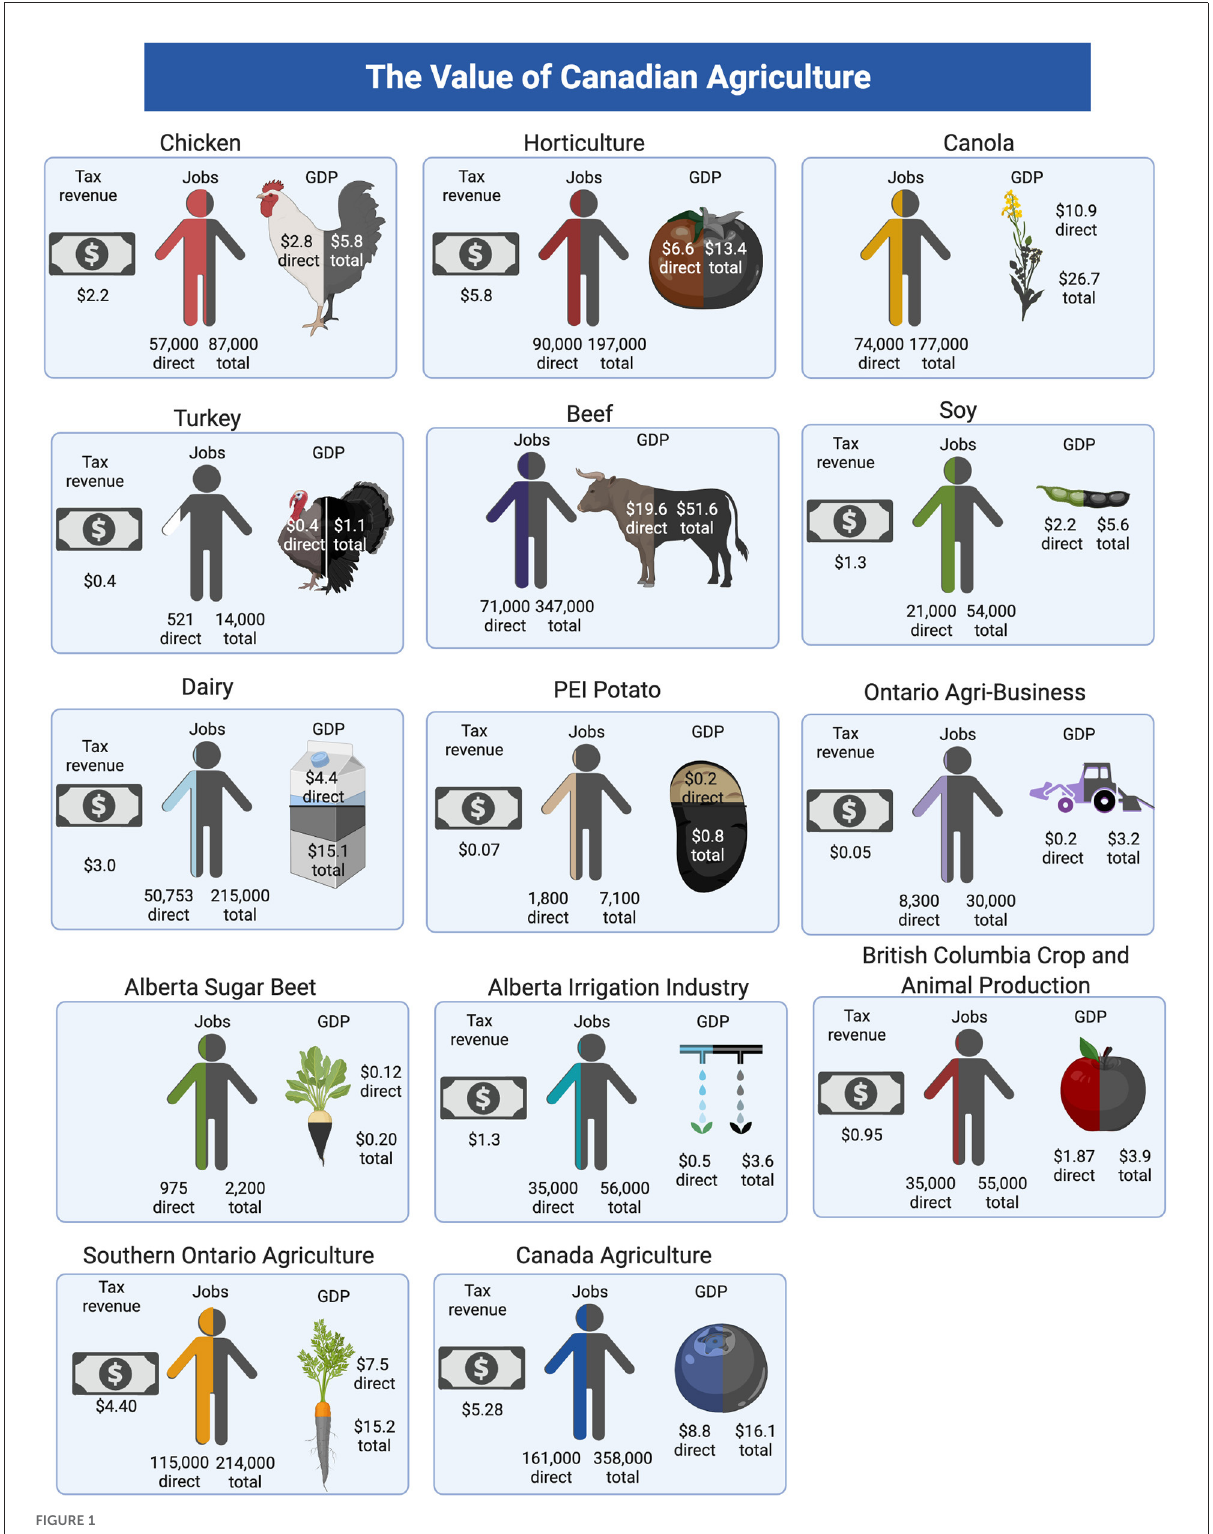
FIGURE1 The value of Canadian agriculture by industry and region. This figure summarizes the direct and total (direct, indirect, and induced) economic impacts in terms of GDP and jobs from 15 input-output analyzes of Canadian agricultural industries. Gross domestic product (GDP) in